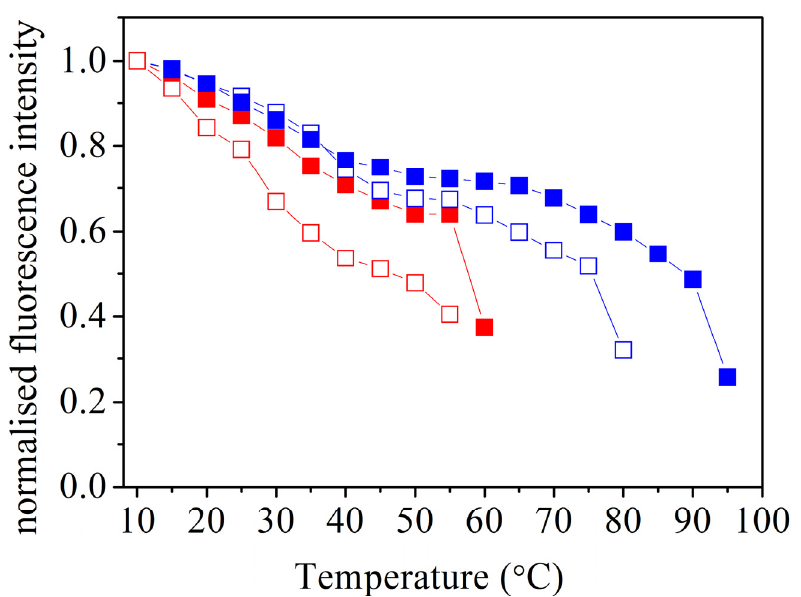
Figure 2. Thermal denaturation of Tm ‐ MreB at different buffer conditions. The tryptophan fluores ‐ cence intensity of Tm ‐ MreB was examined in high ‐ salt (red) or salt ‐ free (blue) environments. In one group of experiments, 2 mM ATP was added to MreB (closed symbols).